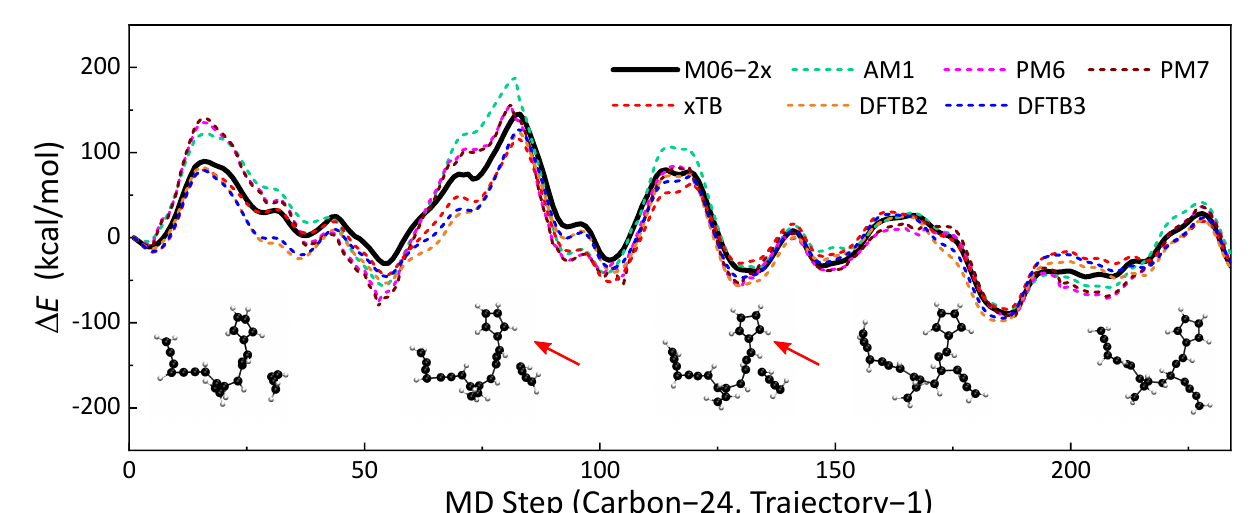
Figure 1. The no. 1 soot trajectory containing 24 carbon atoms was taken as an example; the profiles of ∆ E with MD times obtained by different semi-empirical methods (dotted line) are shown in this figure, and the result of the M06-2x (black line) was used as a reference. Each time step of the molecular dynamics took 0.5